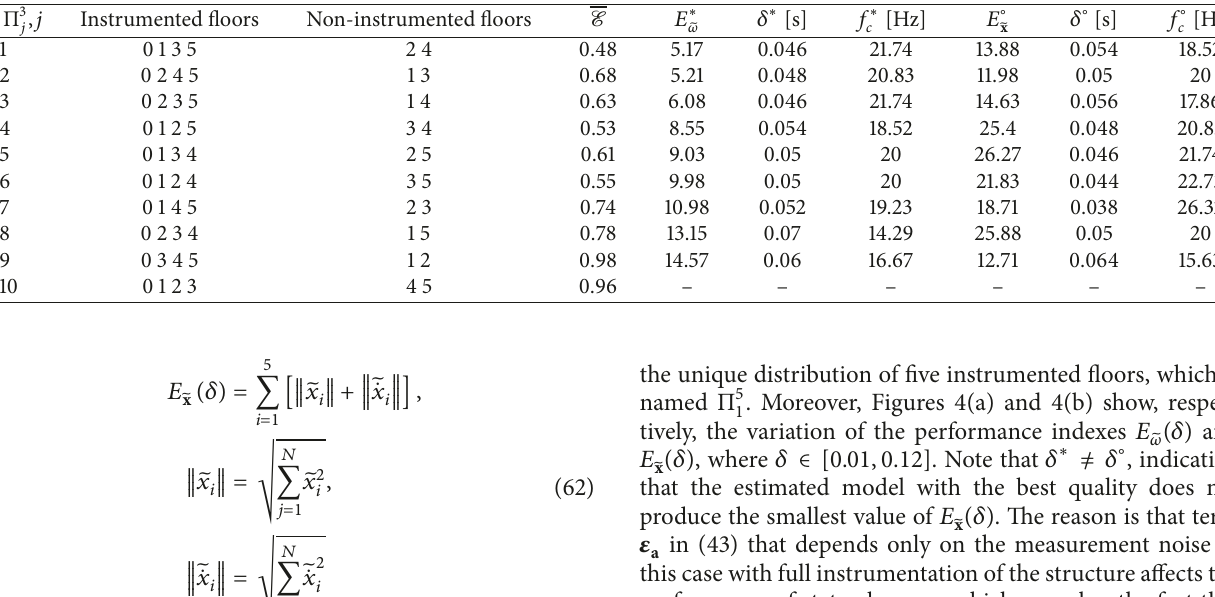
Table 4: Results with three instrumented